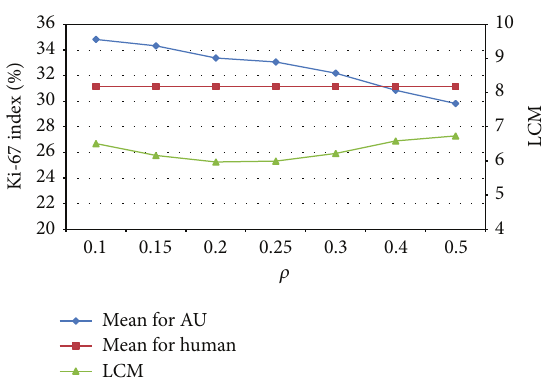
Figure 3: Examination of Ki-67 index and LCM in respect to the 𝜌 factor of the penalty